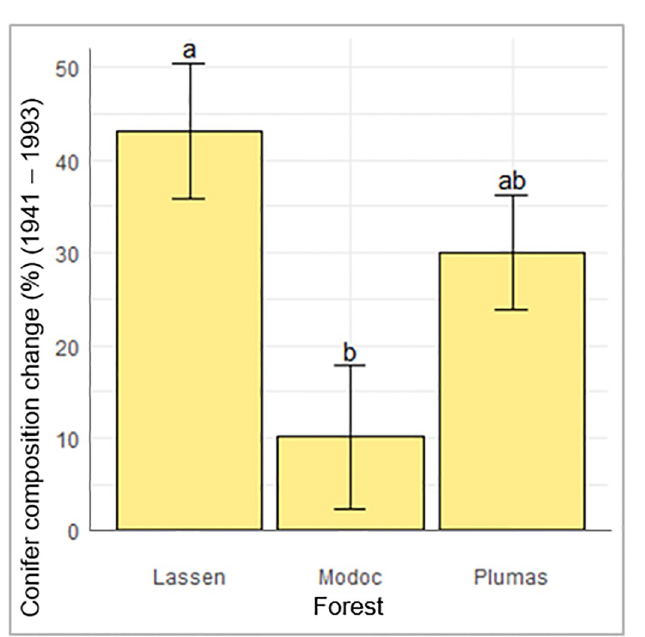
Fig 7. Conifer composition change from 1993 to 1941 differs among forests. Conifer composition on the y-axis shows a change in conifer composition percentage, here all values are positive showing increases among all forests e.g., if a stand’s conifer composition was 20% in 1941 and 70% in 1993, it’s conifer composition change was 50% (e.g. 70– 20 = 50%). Error bars represent standard error of least squares means, and same letter denotes no significant difference among